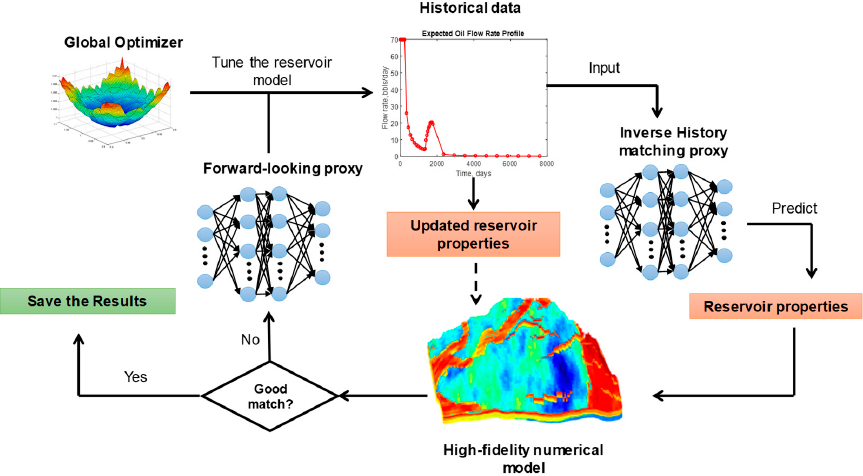
Figure 4. Artificial-intelligence assisted history-matching workflow: Reservoir properties tuning.